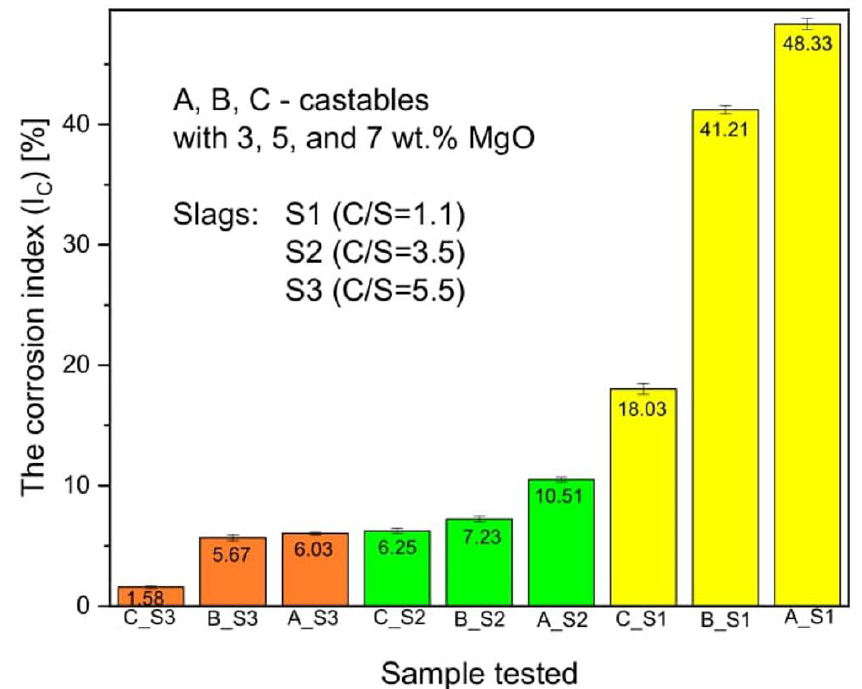
Figure 12. Diagram showing the corrosion index ( I C ) of individual castables samples in contact with the